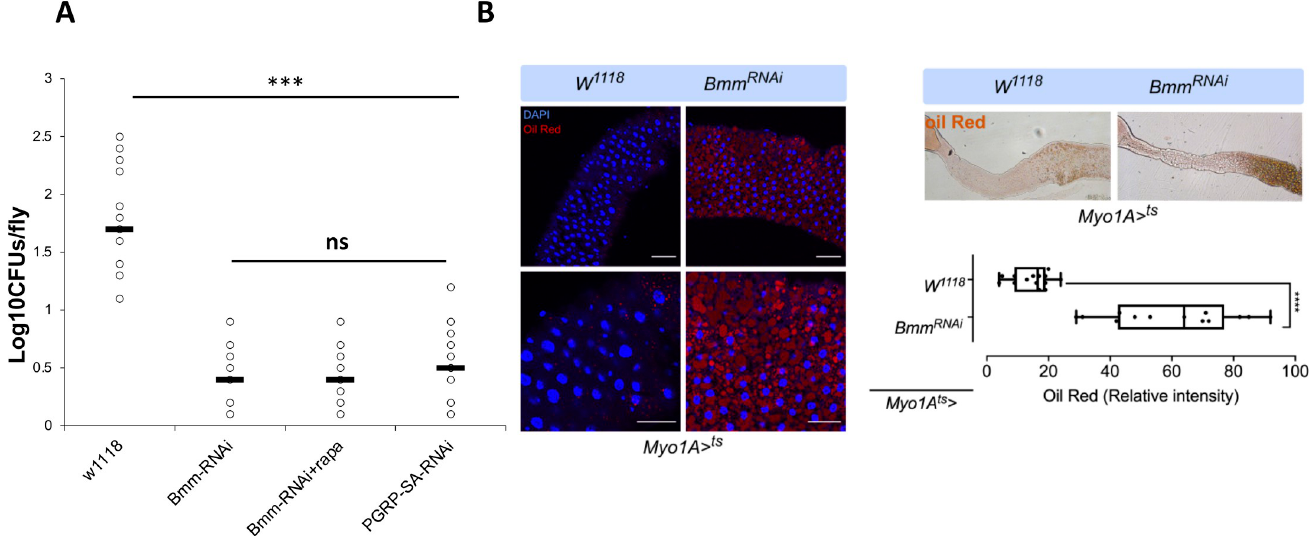
Fig 8. RNAi of the Bmm lipase increases intestinal lipid accumulation and reduces bacterial density. (A) Silencing of bmm expression in enterocytes (through Myo1A ts -GAL4) resulted in significant reduction of enteric CFUs. (B) This was coupled to an accumulation of lipids in the gut as stained and quantified with Oil Red. Statistical comparisons were conducted using student’s t-test (ns = not significant, ��� p < 0.001, ���� p < 0.0001).